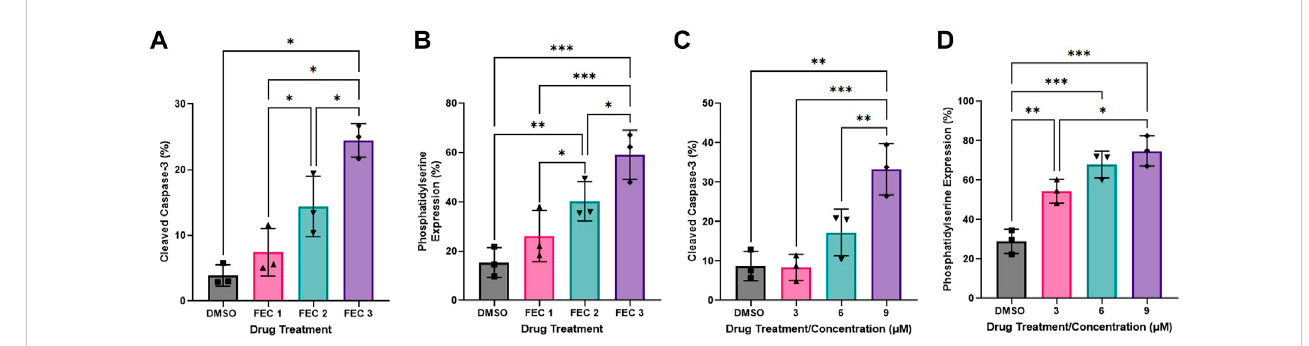
FIGURE 3 Dose-responseeffectsofcombined5- fl uorouracil,epirubicin,cyclophosphamide(FEC; (A,B) anddocetaxel (C,D) onhumancoronaryarteryendothelial cells (HCAEC) phosphatidylserine (A,C) and cleaved caspase-3 expression (B,D) across a range of physiological concentrations at 12- (A,B) and 48-h (C,D) post-exposure.Datashownaremean±SEM( n =3).* p < 0.05,** p < 0.01,*** p < 0.001.FEC1=5- fl uorouracil:1 µM,epirubicin:0.003 µM,cyclophosphamide: